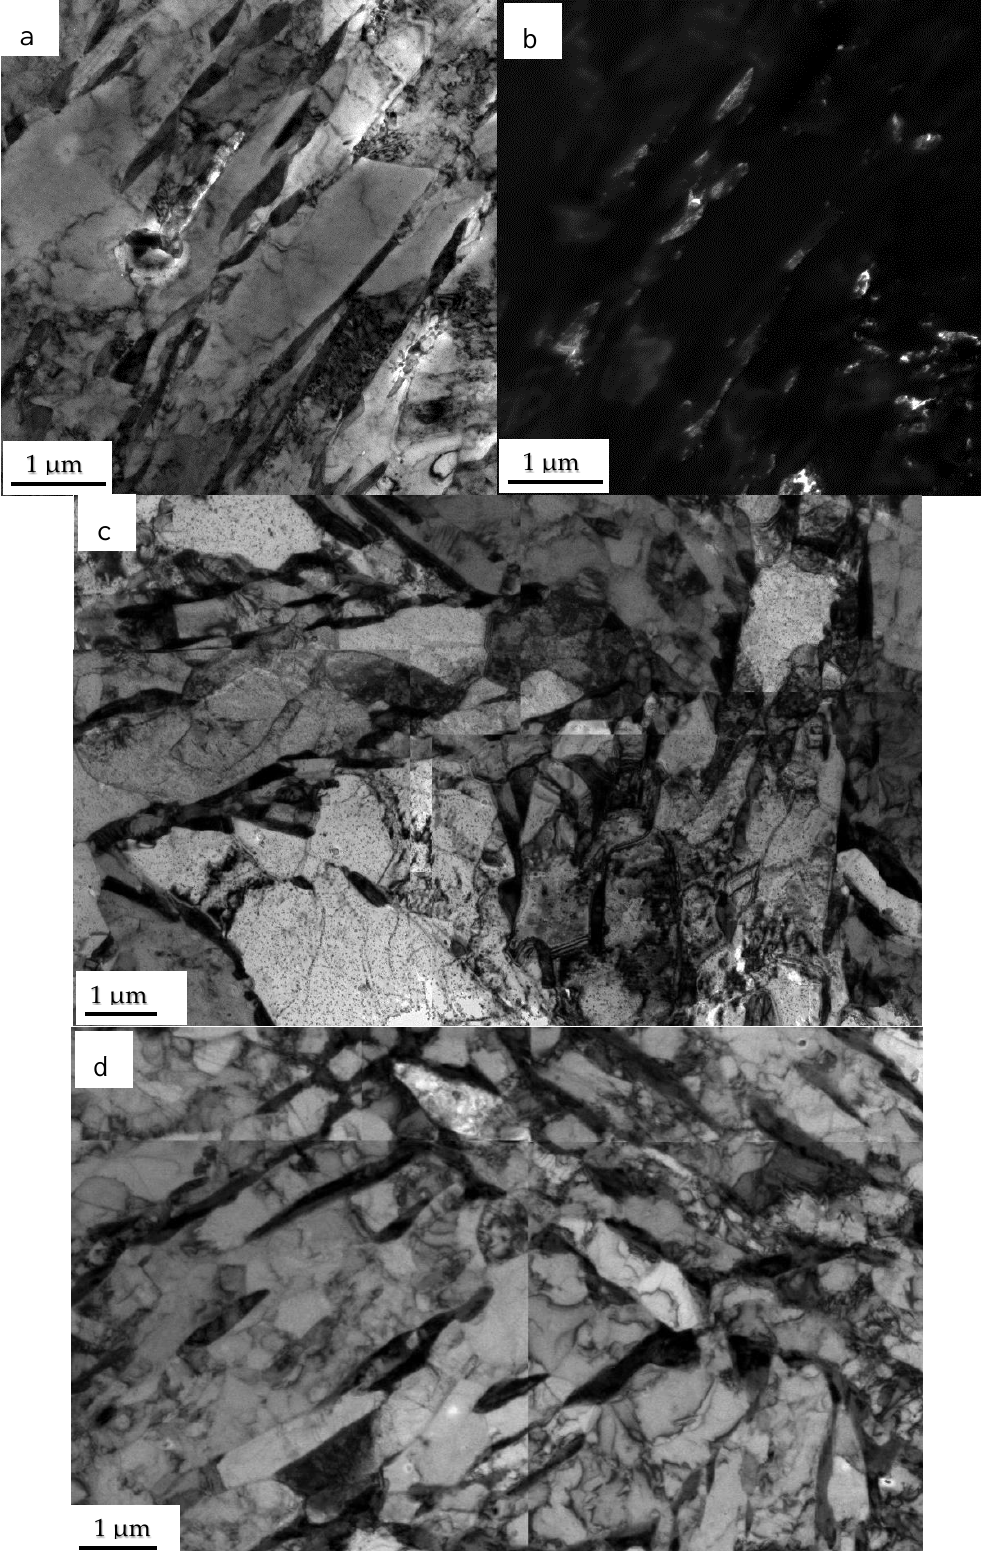
Figure 4. ( a , c , d ) Bright-field TEM images of retained austenite (RA) for samples tempered at 500, 600, and 700 °C, respectively; ( b ) dark-field images of RA in ( a ).